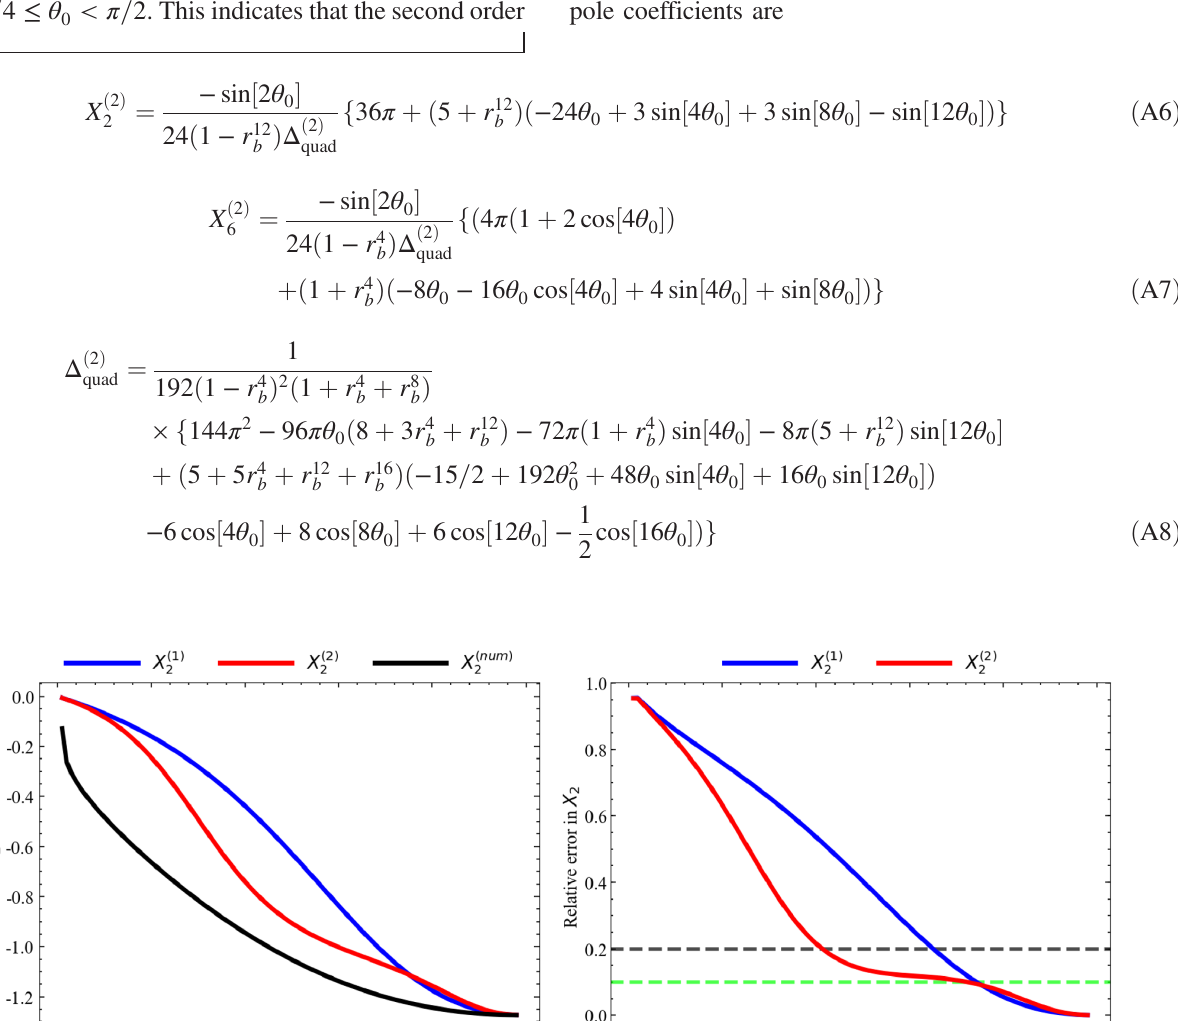
FIG. 18. Left: Analytical approximations to (1st, 2nd) order X ð value X num 2 (black) as functions of θ 0 . Right: The relative error in X ð The dashed green and black lines are shown at the 10% and 20% error levels respectively. In both plots b=a ¼ 0 . 8